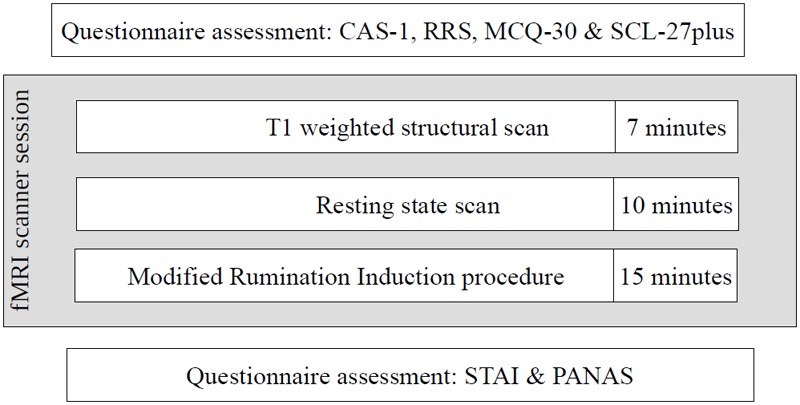
Schematic diagram of the study procedure.